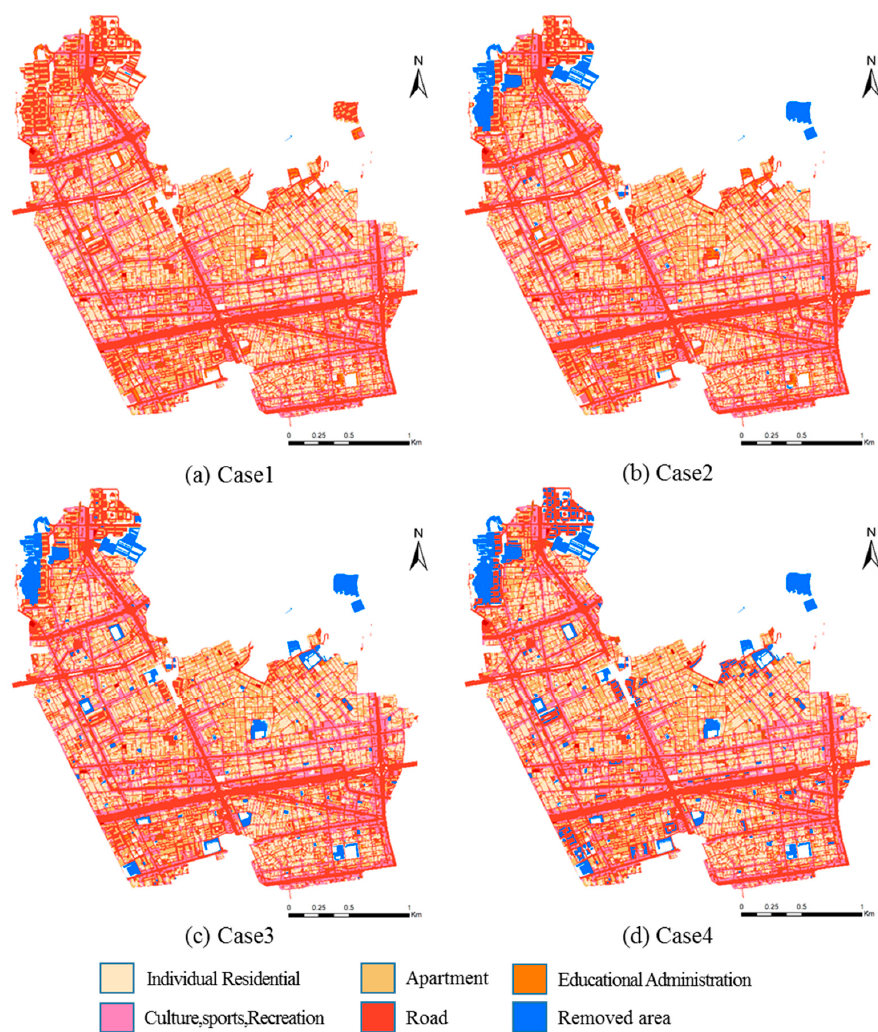
Figure 5. Land use map and total impervious area map identified from the detailed land use cover data of the study area.